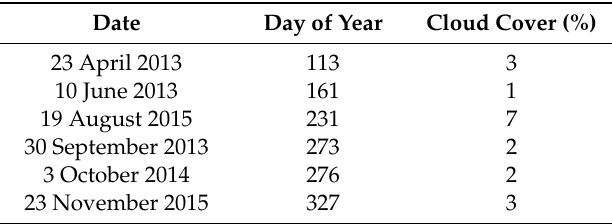
Table 1. Landsat 8 Operational Land Imager (OLI) images used in this study. All images were acquired along path 13 and row 28 (WRS-2) in descending